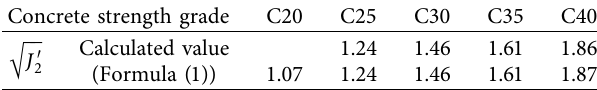
Table 2: Value table of the ultimate shearing strain of concrete.